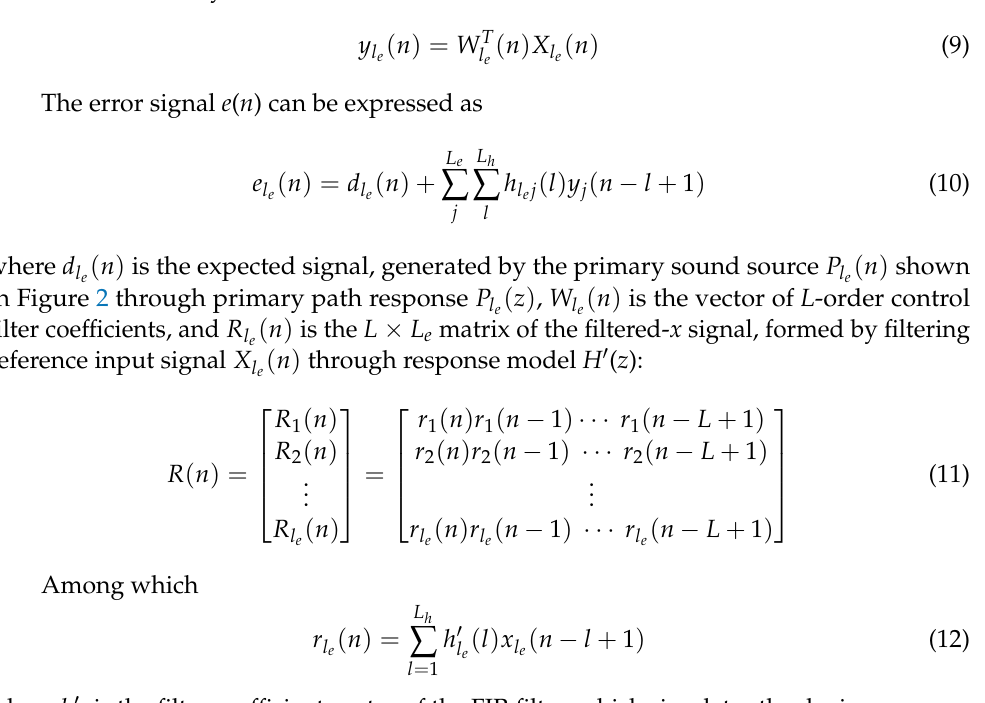
The error signal e ( n ) can be expressed as